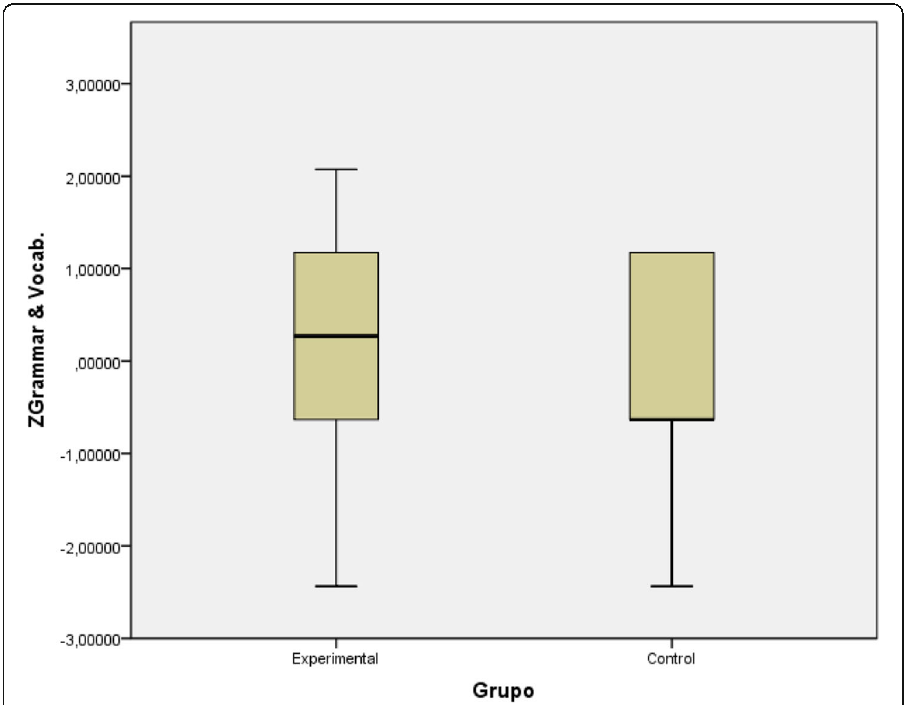
Fig. 6 Box-and-whisker plot of post-treatment progress in variety and accuracy in grammar and vocabulary in both